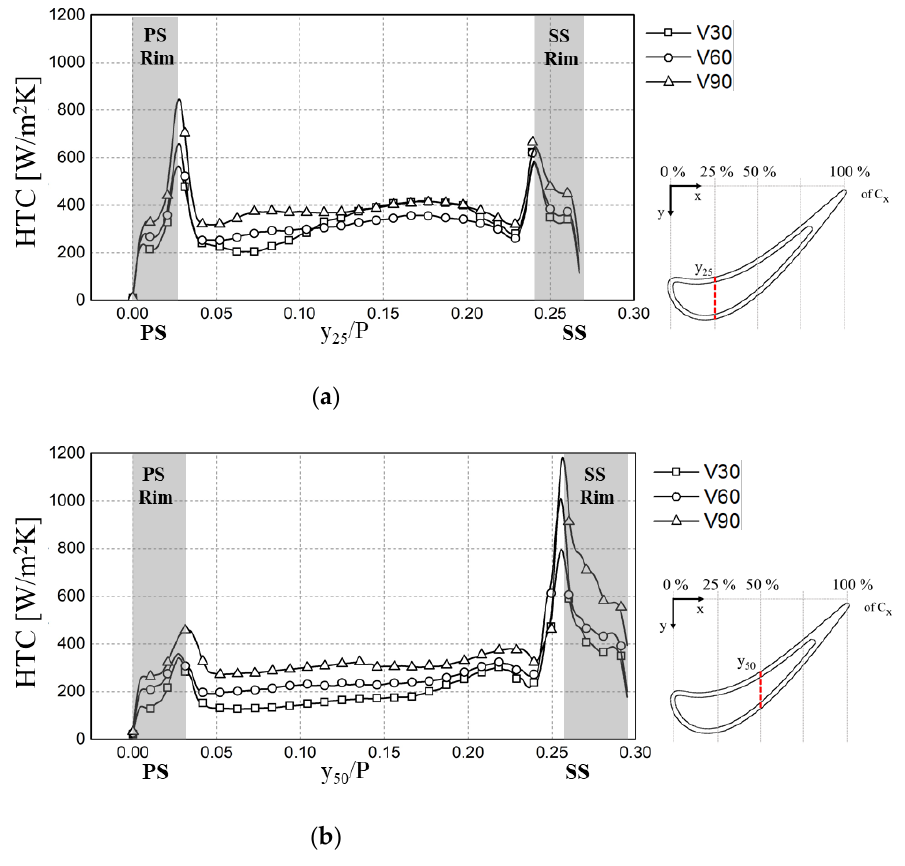
Figure 12. HTC of the squealer tip in the y-direction ( a ) 25%of C x ; ( b ) 50% of C